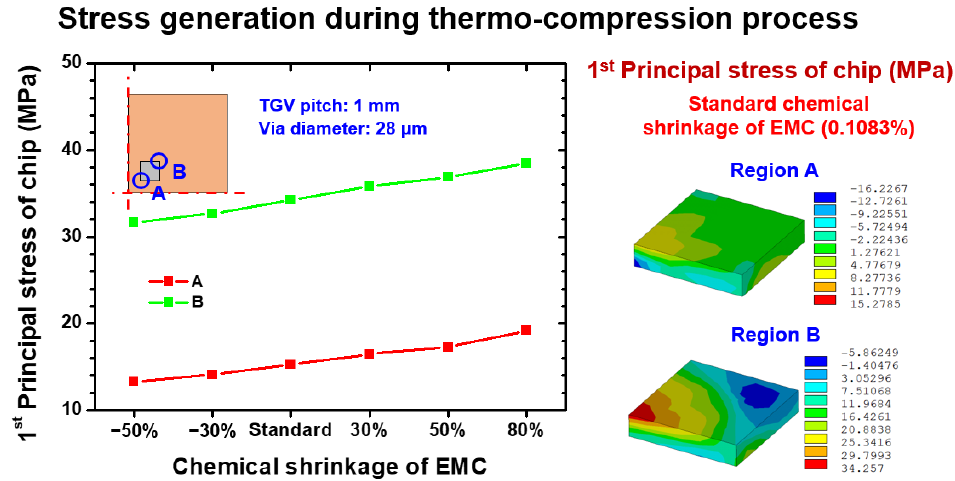
Figure 10. EMC shrinkage dependence first principal stress on the relevant location of the Si chip during the thermocompression